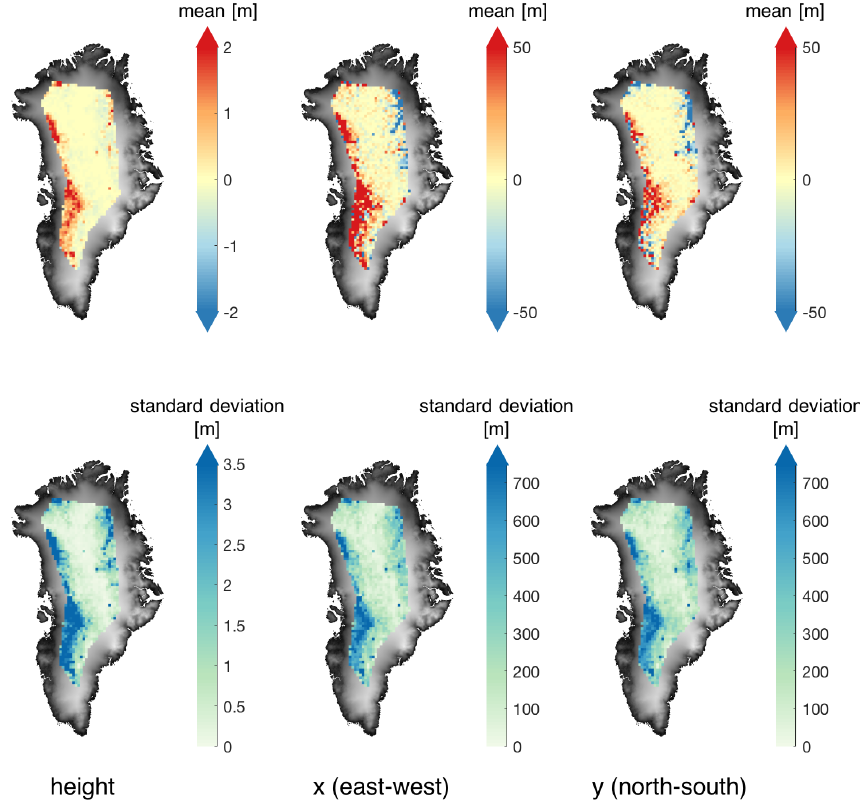
Figure C1. Mean and standard deviation of vertical and horizontal difference in derived impact point P l between (i) using the DEM with a homogeneous vertical displacement (cid:49)h DEM = − 2 . 5m ( (cid:49)h DEM1 ) and (ii) using the original ArcticDEM (DEM orig ). The mapped locations are based on the horizontal locations ( x and y ) derived from DEM orig , tiled by the 25km × 25km grid as in Fig. 6.